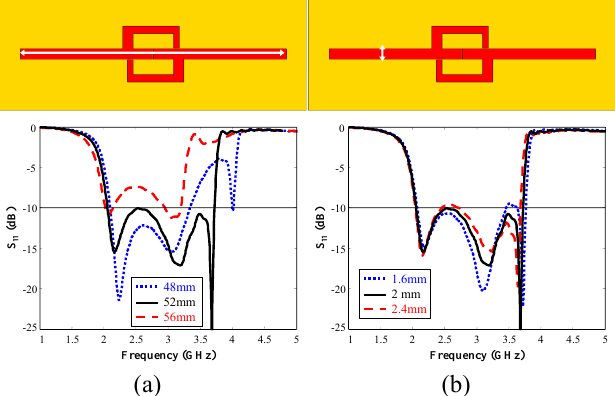
Figure 7: The effects of a) the dipole length b) the dipole width on the return loss performance.